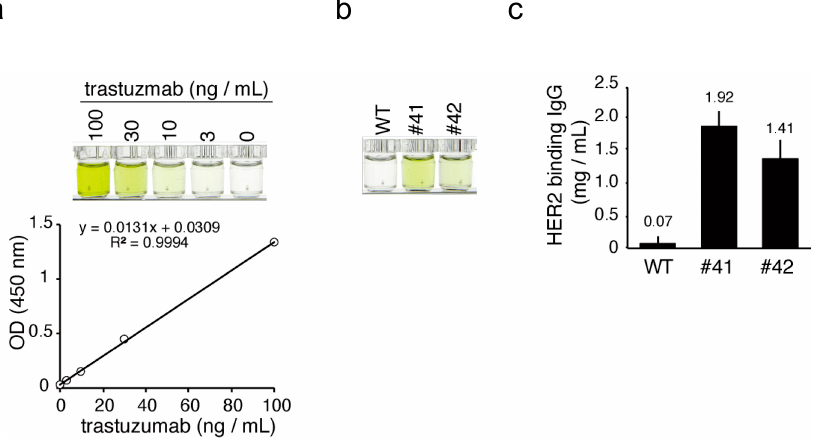
Figure 5. ELISA for HER2 binding hIgG in KI egg whites. ( a ) Top: color development of standard trastuzumab in ELISA. The concentrations of the standard trastuzumab samples are shown at the top of the wells. Bottom: standard curve based on the optical density (OD) values. R 2 is the linear regression R ‐ squared value. ( b ) Color development of HER2 binding hIgG from WT and KI egg whites in ELISA. The WT and KI egg whites were diluted 100,000 ‐ fold and subjected to ELISA. The OD values of samples from WT, #41, and #42 eggs were 0.03, 0.34, and 0.17, respectively. ( c ) The concentrations of HER2 binding hIgG in egg whites as estimated by ELISA. Bars show the mean ± standard deviation of the concentration of HER2 binding hIgG in each egg white sample ( n = 3).